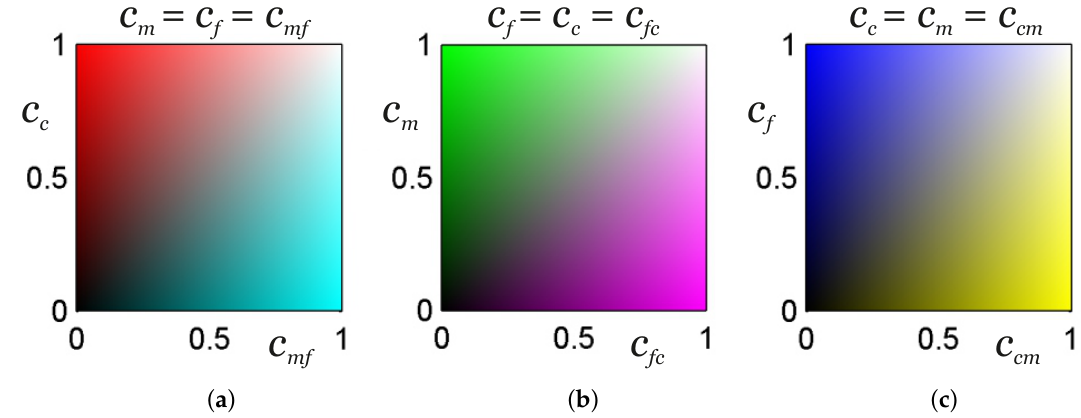
Figure 1. Palettes of colors correspond to different combinations of relative concentrations of three dust fractions. The subscripts c , m , f correspond to the concentrations of fractions of coarse, medium-sized and fine grains, respectively. Three sections of the cubic color palette are presented, for which the values of the concentrations of the two fractions coincide. The area in the upper left corner corresponds to the predominance of one fraction of dust particles over the other two. The right lower corner corresponds to the predominance of two dust particles simultaneously over the third one. Colors in the lower left corner correspond to a low concentration of all three fractions. The colors in the upper right corner correspond to the concentrations of all three fractions, close to the maximum. The state of the mixture, in which the concentrations of all three fractions are the same, is represented by shades of gray: from black, when the concentrations are zero, to white, when the concentrations are